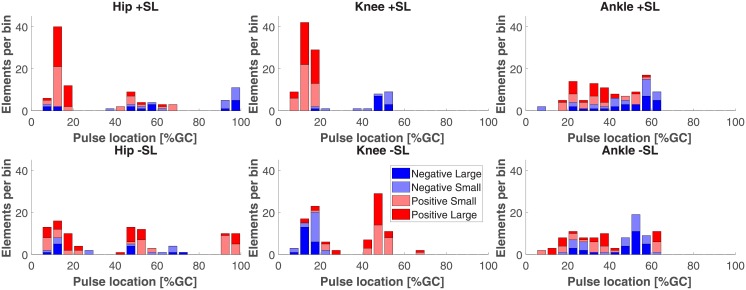
Histogram of one pulse approximation locations in gait cycle, sorted by pulse amplitude sign and magnitude.